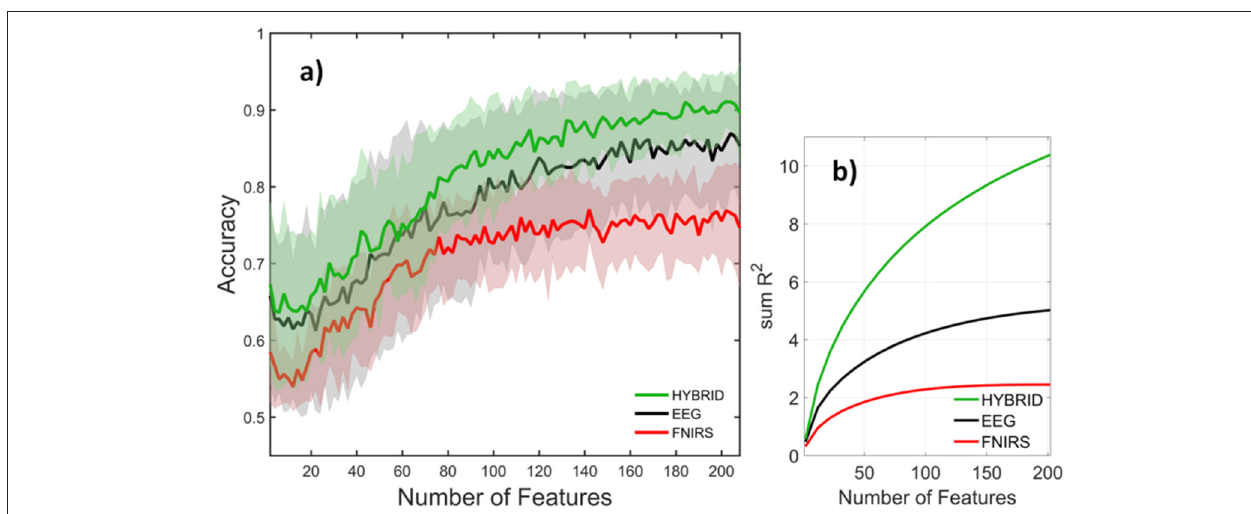
FIGURE 11 | (a) Accuracy and (b) cumulative sum of R 2 for EEG (black), fNIRS (red), and Hybrid (green) systems as a function of system size. Mean and standard deviation over subjects are indicated by the solid curves and shaded areas, respectively. The classification task was rest v 3-back and feature window size was 5 s.